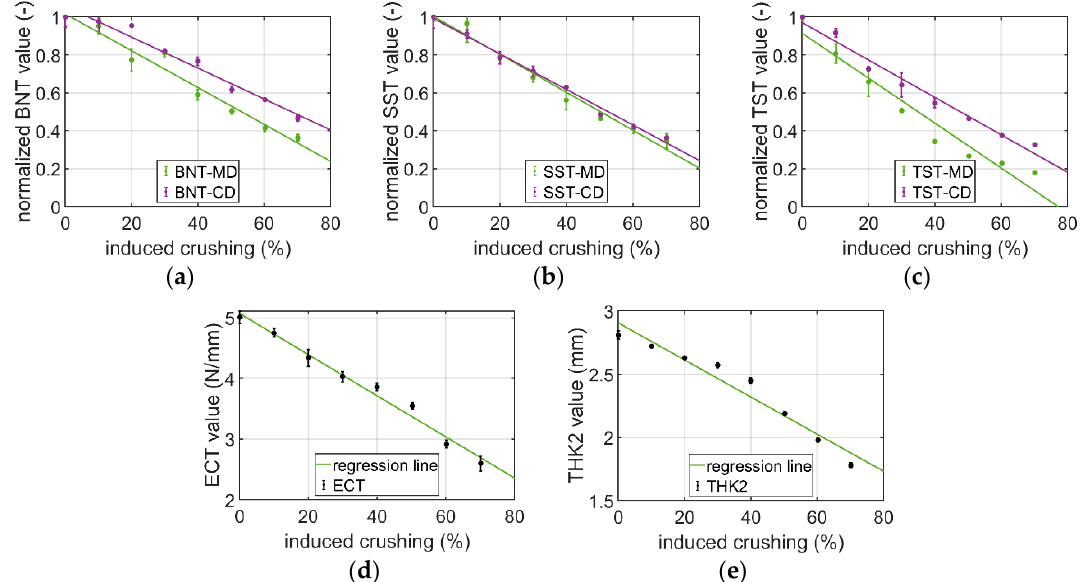
Figure 11. The decreases in measured values for B-410 corrugated cardboard in: ( a ) BNT; ( b ) SST; ( c ) TST; ( d ) ECT and ( e ) THK2.